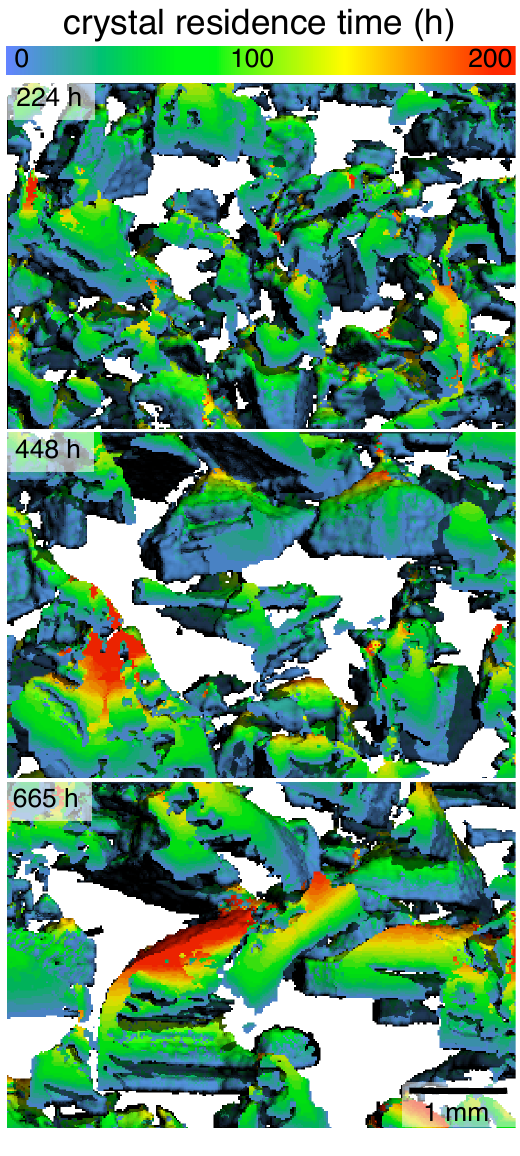
Fig. 6. Visualization of residence time with data from Series 2, of which the structure is shown in Fig. 5. The bottom of the struc- tures are deposition sites for vapor, therefore the youngest ice vox- els can be found there. The topmost parts, where sublimation takes place, host the oldest voxels. Note that even for the largest struc- tures, the residence time of voxels rarely reaches 200h. The direc- tion of the temperature gradient (which coincides with z -axis) is shown in Fig.